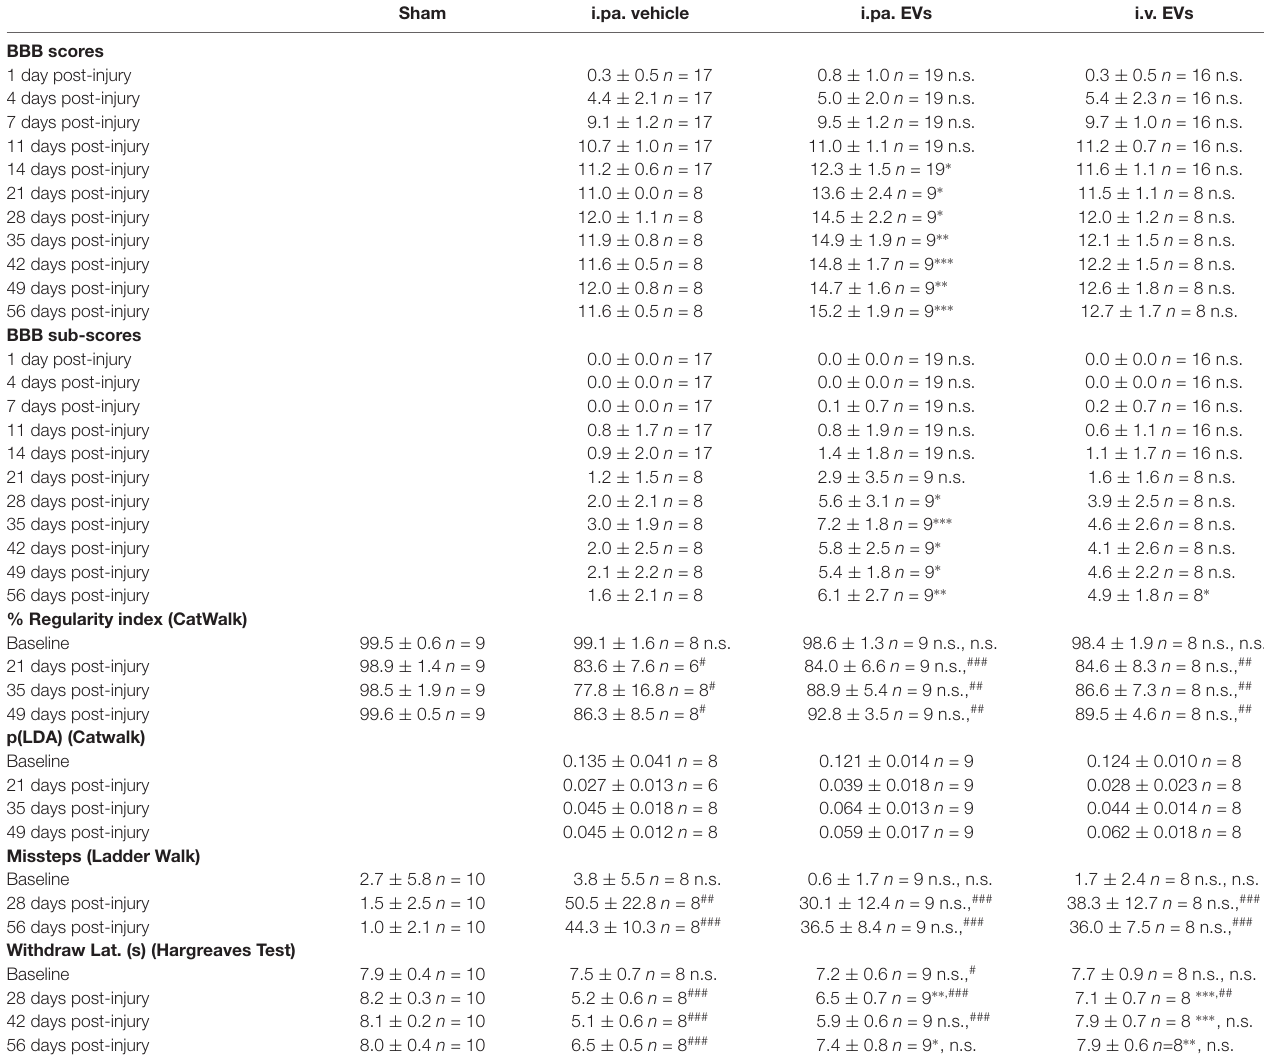
TABLE 1 | Summary of functional